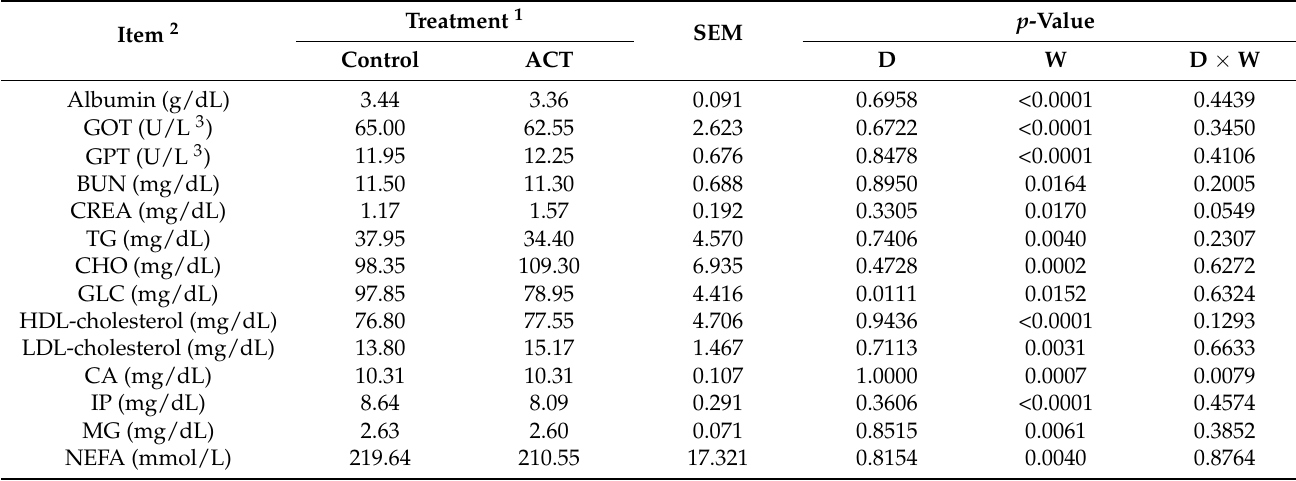
Table 11. Serum metabolic profile in